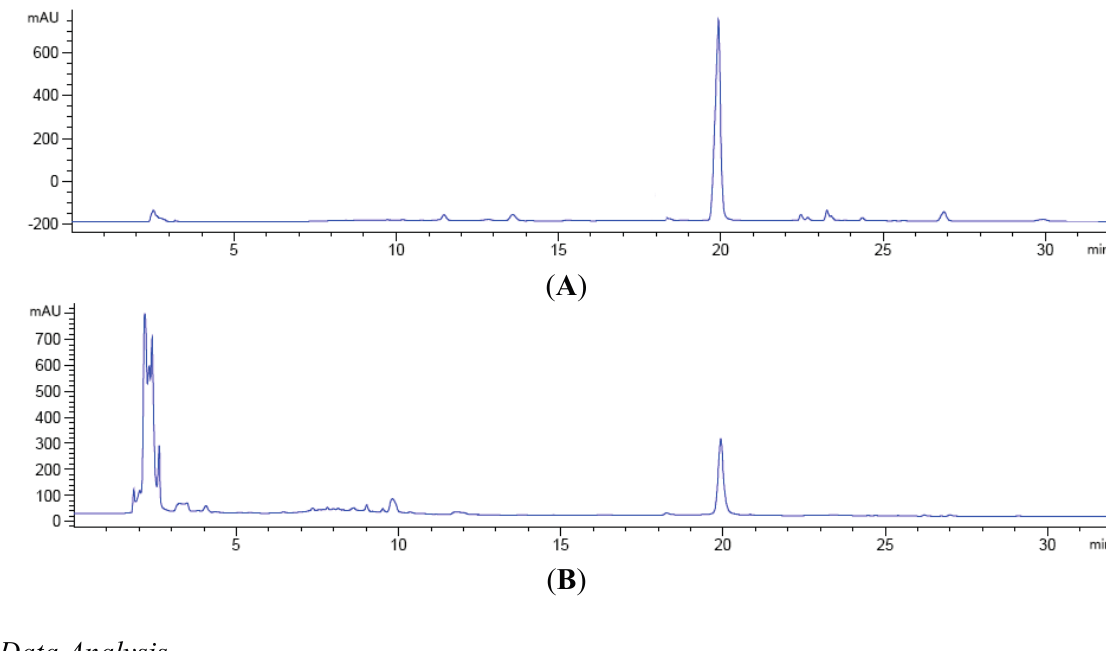
Figure 4. RP-HPLC chromatograms of Nsh standards ( A ) and fermentation samples of 208 h ( B